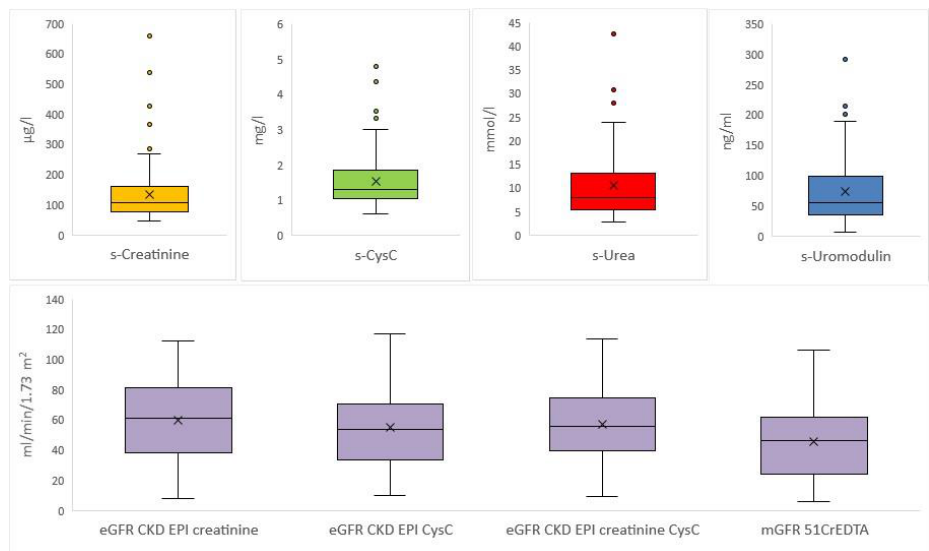
Figure 1. Boxplots for each parameter of glomerular filtration rate. Boxplots for serum creatinine concentration (s-Creatinine), serum cystatin C concentration (s-CysC), serum urea concentration (s-Urea), serum uromodulin concentration (s-Uromodulin), estimated glomerular filtration rate with Chronic Kidney Disease Epidemiology Collaboration study formula with s-Creatinine (eGFR CKD EPI creatinine), estimated glomerular filtration rate with Chronic Kidney Disease Epidemiology Collaboration study formula with s-CyC (eGFR CKD EPI CysC), estimated glomerular filtration rate with Chronic Kidney Disease Epidemiology Collaboration study formula with s-Creatinine and s-CysC (eGFR CKD EPI creatinine CysC), and measured glomerular filtration rate with Chromium-51-ethylenediaminetetraacetic acid clearance (mGFR 51 CrEDTA).